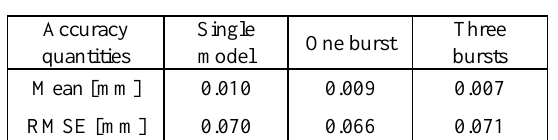
Table 10. Bias and RMSE of the estimated 𝑍 amplitudes between the photogrammetric system and the laser transducers (3 Hz)